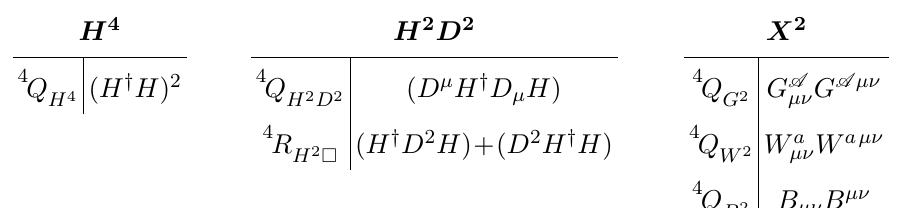
Table 1 . Bosonic dimension-two operator in the SM (and the SMEFT).